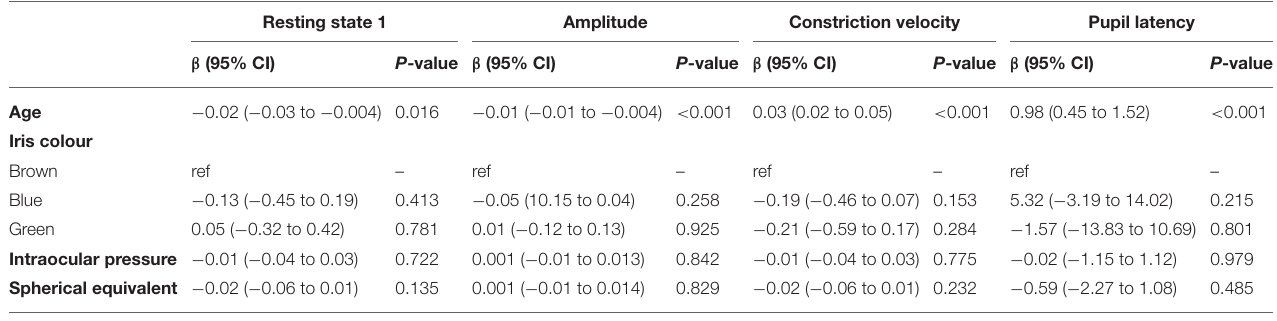
TABLE 3 | Mean left eye pupil measurements for resting pupil diameter, PLR amplitude, constriction velocity (CV) and pupil latency for brown, green and blue eyes. Resting state 1 (left): mean (sd, range)